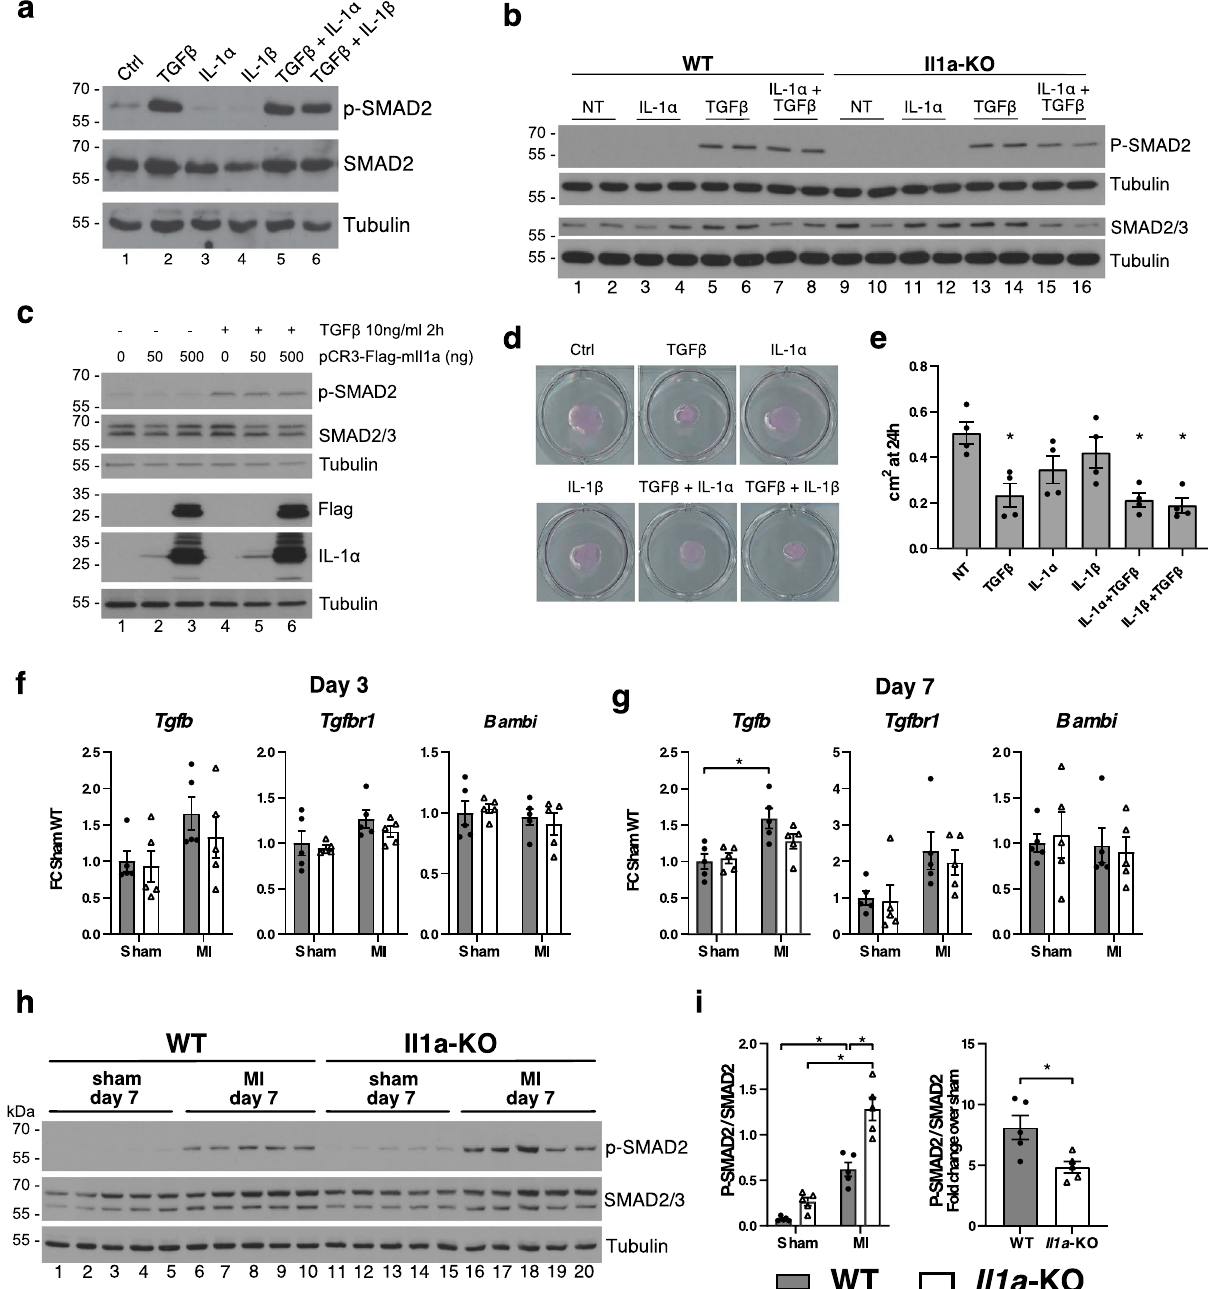
Figure 3. Role of IL-1α on TGFβ signaling in cardiac fibroblasts in vitro and in the infarcted myocardium in vivo. ( a ) Phosphorylation of SMAD2 in adult mouse cardiac fibroblasts cultured for 2 h in the presence of 10 ng/ml TGFβ, 10 ng/ ml IL-1α or IL-1β alone or in combination. Blots from one representative experiment (n = 3). ( b ) Protein expression of SMAD2/3 and phospho-SMAD2 in adult mouse cardiac fibroblasts stimulated for 2 h with 10 ng/ml IL-1α or 10 ng/ml TGF-β, alone or in combination. Blots from one representative experiment (n = 3). ( c ) Protein expression of SMAD2/3 and phospho-SMAD2, and expression of IL-1α in HEK 293 T transfected with varying doses of pCR3-Flag-mIl1a vector and stimulated with 10 ng/ml TGF-β for 2 h. Blots from one representative experiment (n = 3). For ( a – c ), target proteins and loading controls (tubulin) done on the same blots were grouped together. ( d ) Contraction of collagen pads populated with adult murine cardiac fibroblasts stimulated for 24 h with 10 ng/ml TGFβ, 10 ng/ml IL-1α or IL-1β, alone or in combination. Pads are from one representative experiment. ( e ) Collagen pads surface areas in cm 2 measured after 24 h stimulation as described in ( d ) (n = 4/condition). ( f , g ) mRNA expression of Tgfb, Tgfbr1 and Bambi in the myocardium, three ( f ) and seven ( g ) days after myocardial infarction (MI) or sham surgery (Sham). The mRNA expressions were detected by RT-PCR, normalized to Rps18 housekeeping genes expression and expressed as fold- change (FC) over sham WT. ( h ) Protein expression and phosphorylation of SMAD2 in the myocardium seven days after MI or sham MI in WT and IL-1α KO mice. Tubulin showed as loading controls. ( i ) Quantification of images shown in ( h ) expressed as p-SMAD2/SMAD2 ratios and as fold change over sham. ( f – i ), N = 5/ group. * p <